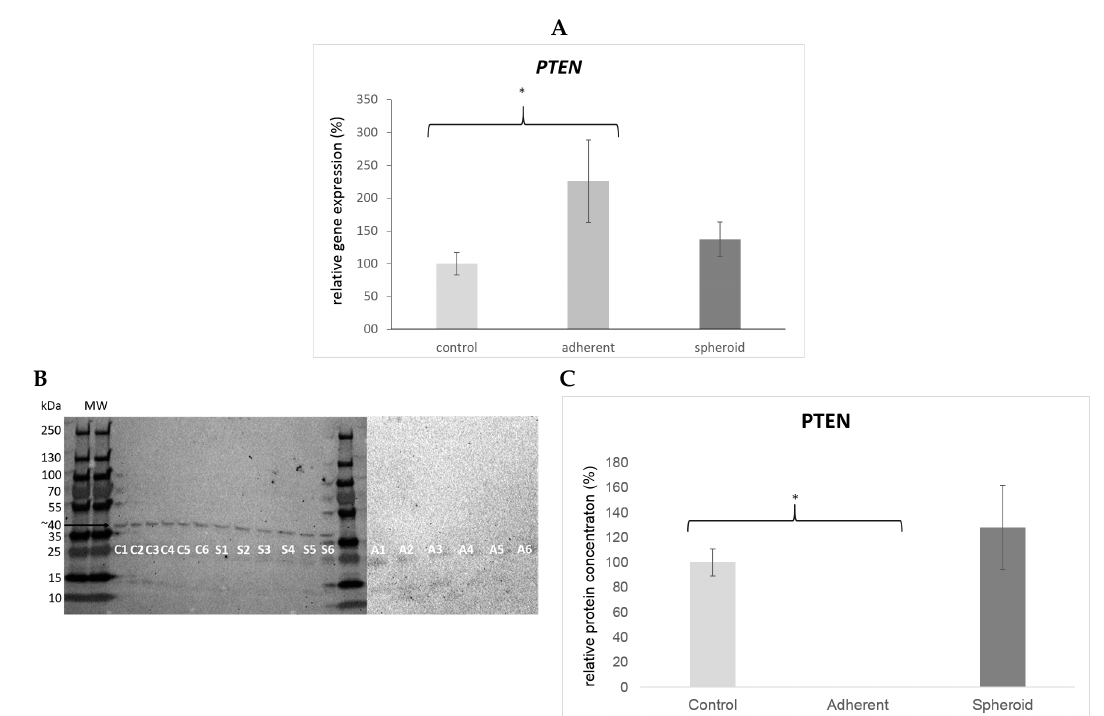
Figure 9. ( A ) SOX2 gene expression was significantly upregulated in the adherent cells under Figure 8. ( A ) PTEN gene expression was significantly upregulated (2.3 × , * p < 0.05) in the adherent simulated microgravity (1.9×, * p < 0.05). Upregulation did not reach statistical significance in the cells under simulated microgravity but not in the spheroids (1.4 × , n.s.). ( B ) Western blot bands showing PTEN protein production (molecular weight 47 kD). Each lane 1–6 shows protein from one independent experiment (C: 1-g control, S: spheroids A: adherent cells under simulated microgravity). The bar graph below shows the average density of the blots from the respective experimental group (controls, adherent cells under simulated microgravity, spheroids). PTEN protein production was suppressed below detection level in the adherent cells under simulated microgravity and showed no significant di ff erence compared to the 1-g-control in the spheroids. ( C ) Mean intensity of the bands in the respective group, intensity of controls defined as